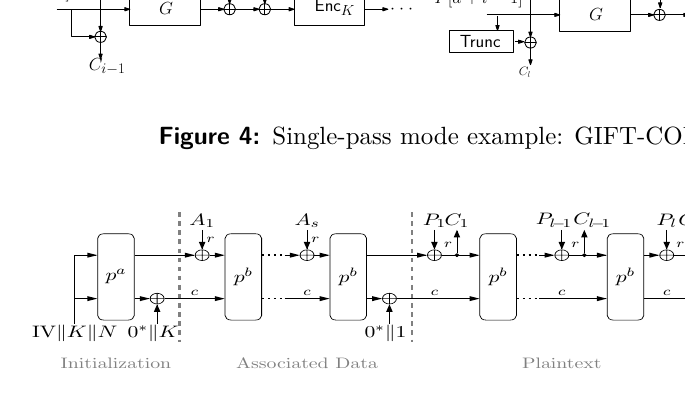
Figure 5: Single-pass mode example: